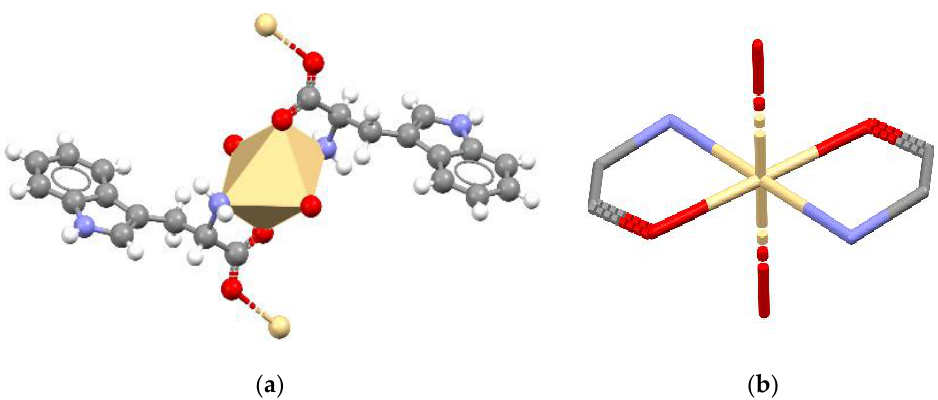
Figure 6. ( a ) The molecular conformation of the complex FUBCIP; ( b ) coordination sphere.